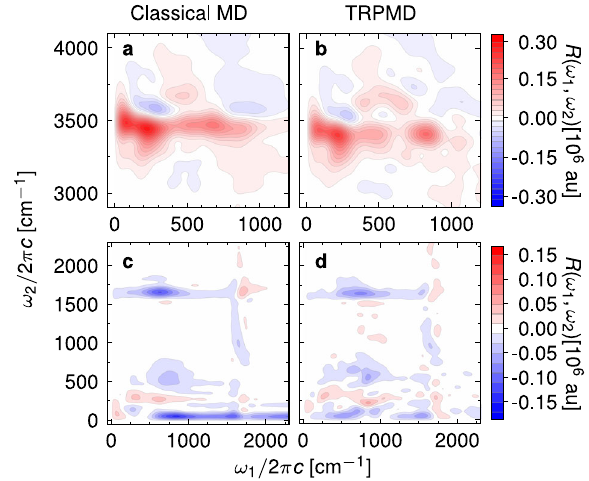
Fig. 7 | Nuclear quantum effects on the IIR spectrum. Two-dimensional IIR spectra of liquid water at 280K, simulated with equilibrium-nonequilibrium MD ( a , c ) and TRPMD ( b , d